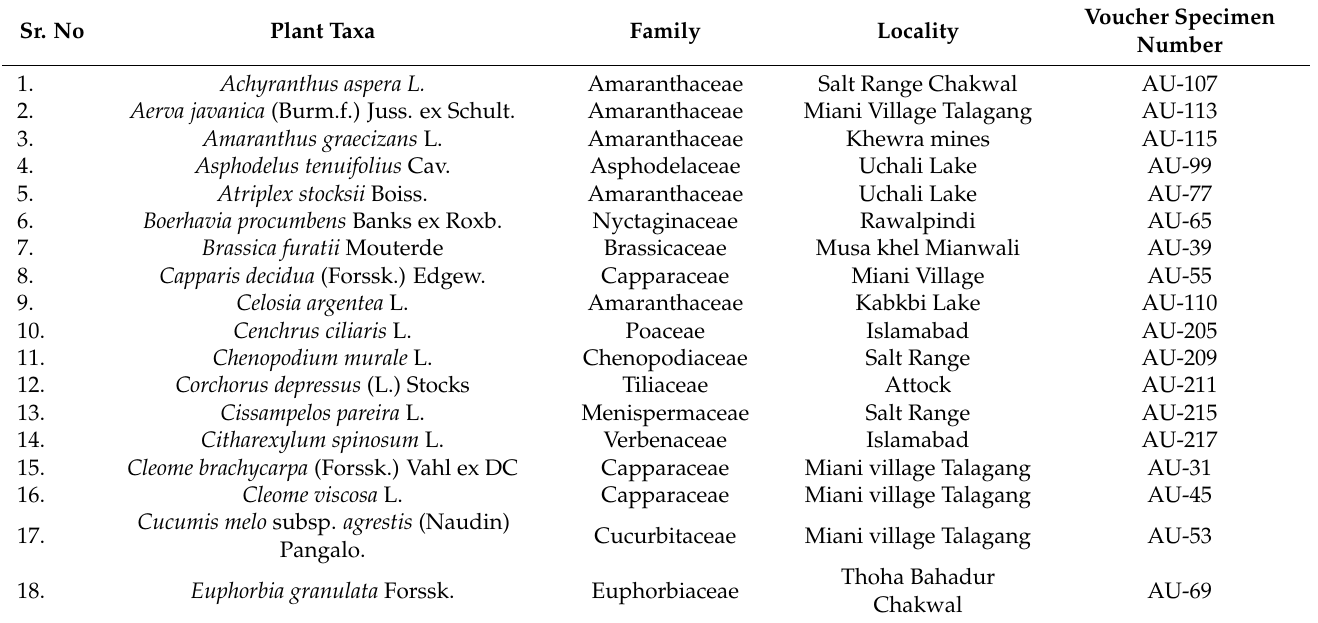
Figure 1. Map of the collection sites of the study area. (Source: Google). Table 1. Weed samples collected from the Potohar